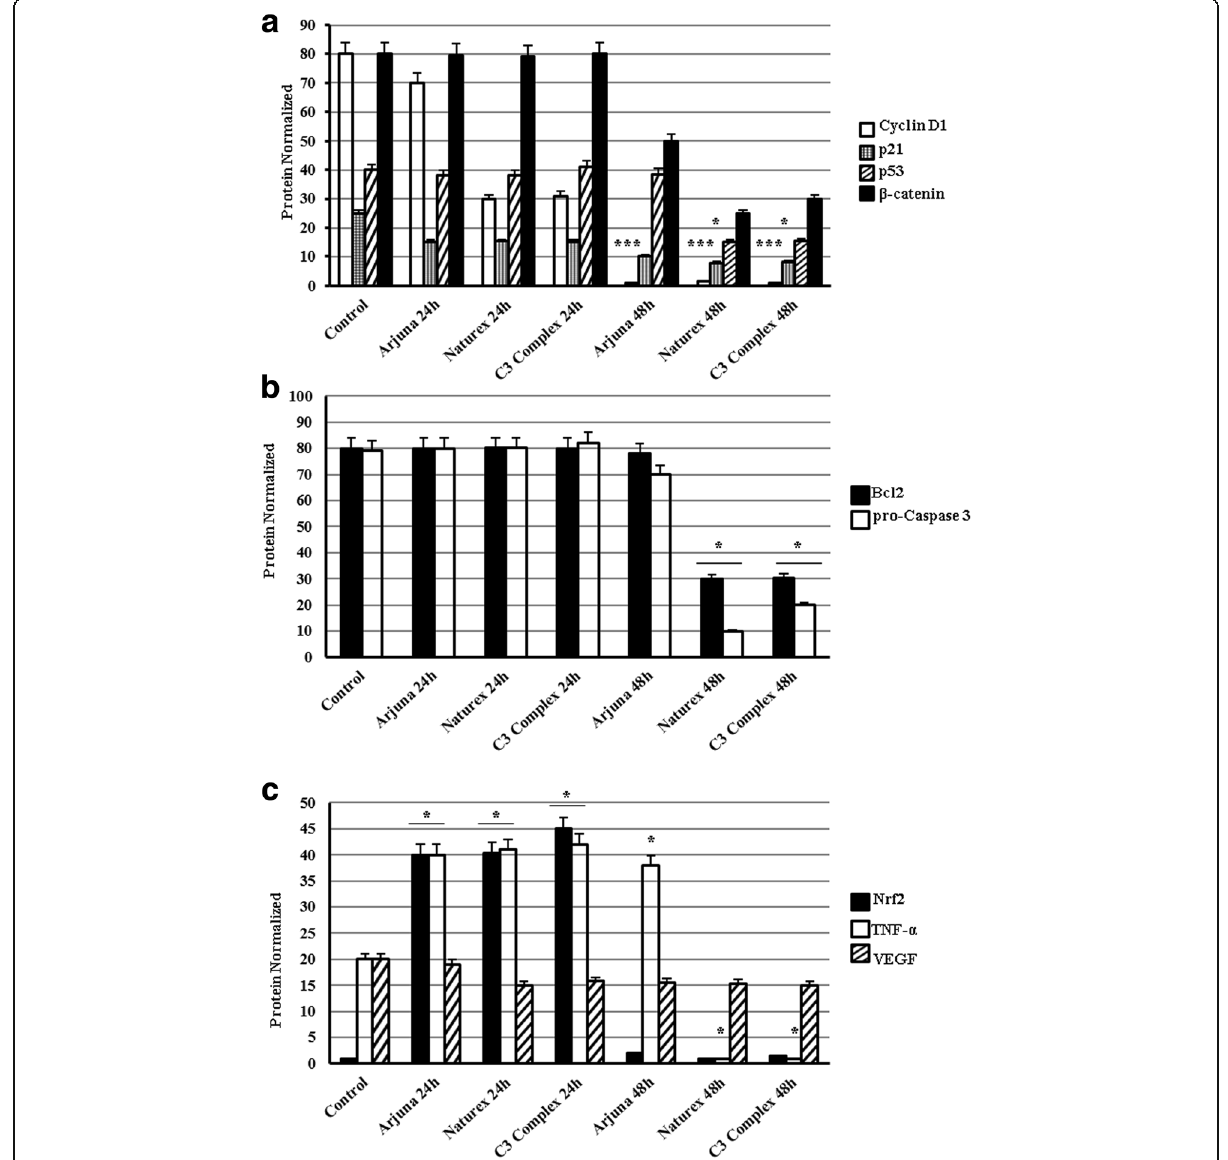
Fig. 2 Western blot analysis of the expression level of Cyclin D1, p21, p53, β -Catenin ( a ), Bcl2, pro-Caspase3 ( b ), Nrf2, Tnf- α , VEGF ( c ) of cells pretreated with the three different extracts of Curcuma (Arjuna®, Naturex®, C3Complex®) with 25 μ M for 24-48 h. Densitometric analysis of the western-blot bands was made using ImageJ software, and from the analysis it was obtained the histogram. β -Tubulin was monitored as a loading control. All data represent as the means ± SEM of three independent experiments. p <0.05*, p <0.01**, p <0.001*** vs. the control (untreated cells)